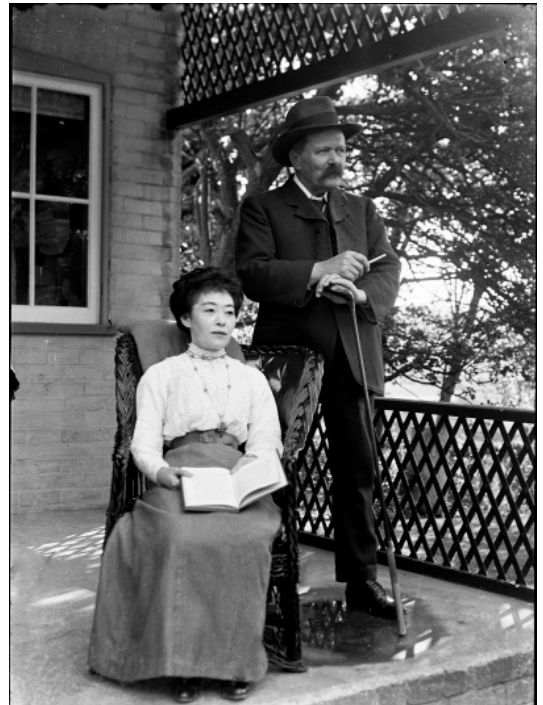
Figure 8. John and Tone Milne on the verandah of their home in the Isle of Wight, c. 1895–1913. Milne, the inventor of the seismograph, met Tone during his time in Japan, her native country. The pair eventually moved to the Isle of Wight where they set up a laboratory. Tone resided in Britain for another six years after Milne’s death in 1913 before returning to Japan. Image © Carisbroooke Castle Museum.